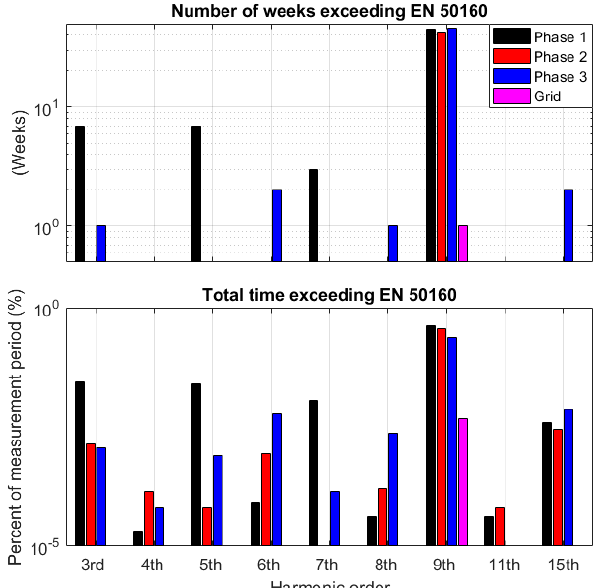
Figure 23. The number of times the individual harmonics exceeded the 10 min limits in EN 50160 ( top ) and the amount of time during the measurement period (48 weeks in islanded operation and 54 weeks in grid-connected operation) in which the individual harmonics exceeded the limits in EN 50160 ( bottom ) for islanded and grid-connected operation. Note the logarithmic vertical scale. The number of weeks and amount of time in which the individual harmonics exceeded the limits in IEEE 519-2014 are shown in Figure 24.